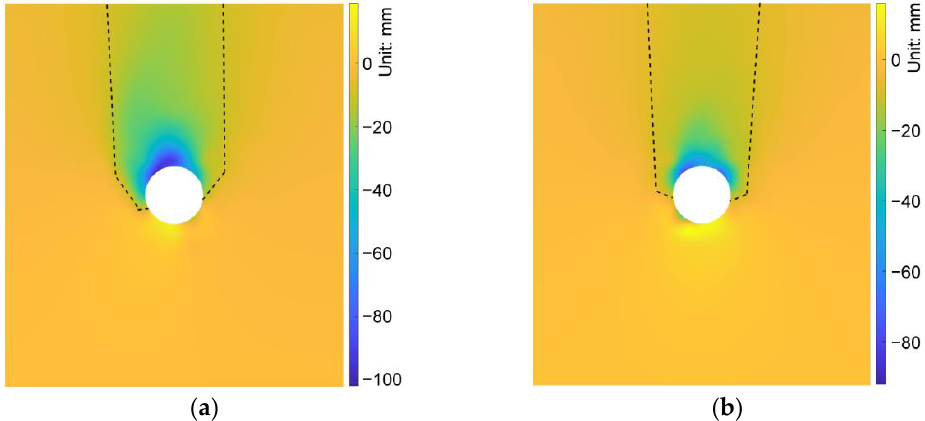
Figure 19. Distribution of the ground settlement in the cases of ( a ) AR4C3 and ( b ) AR6C3.